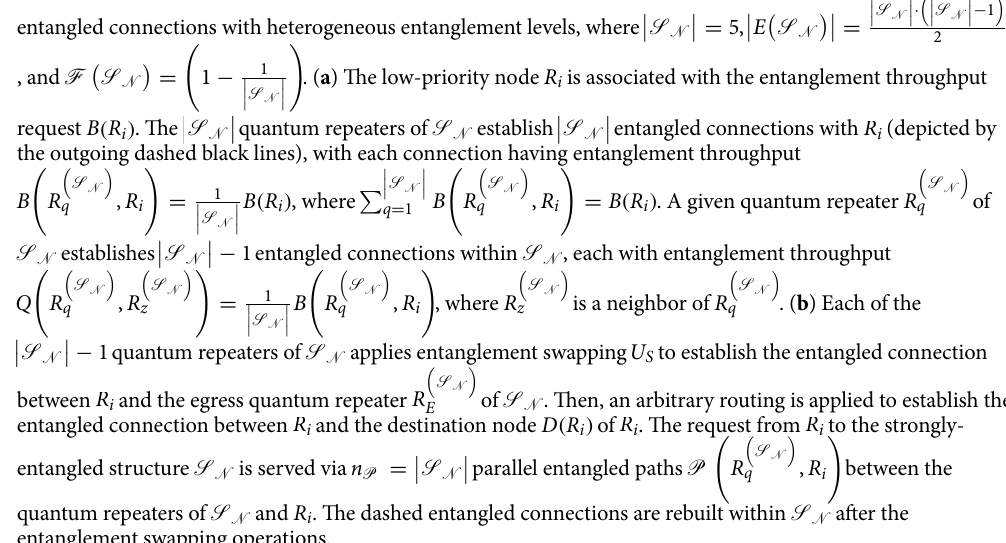
Figure 4. The strongly-entangled structure S N as formed